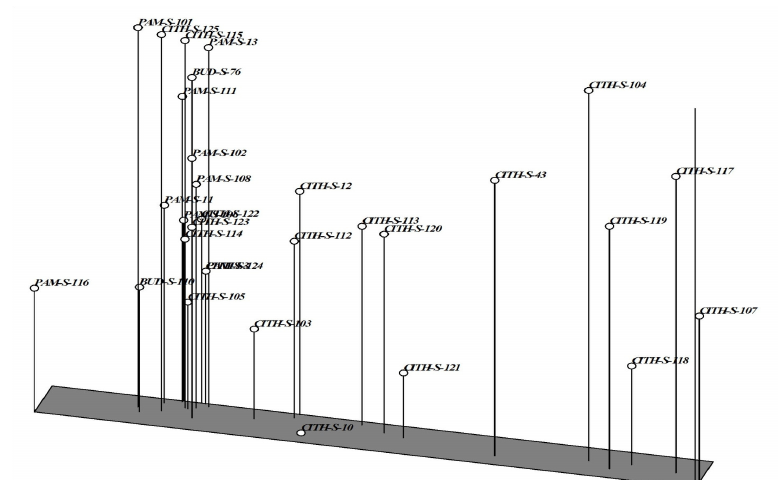
Fig. 2. Three dimensional PCO (principal co-ordinate analysis) scaling of 31 saffron genotypes using RAPD, ISSR and SSR markers